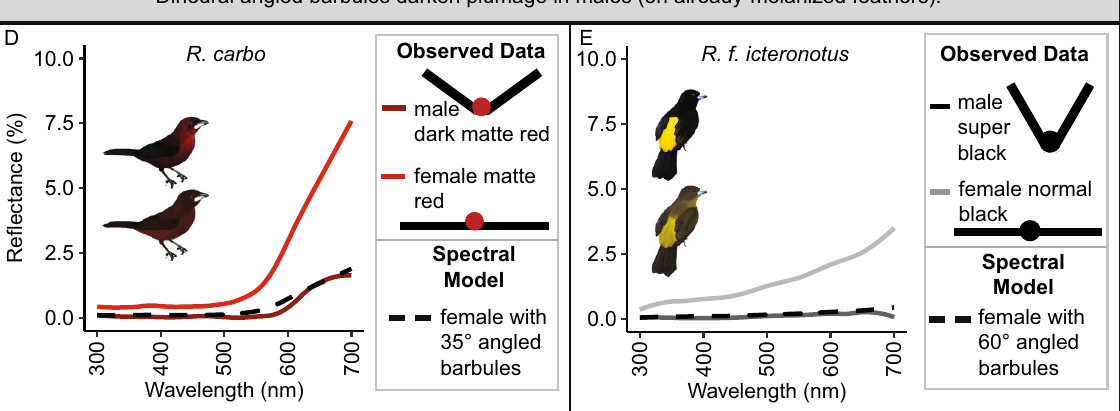
Velvet Red and Super Black Males vs. Brighter Females: Dihedral angled barbules darken plumage in males (on already-melanized feathers).